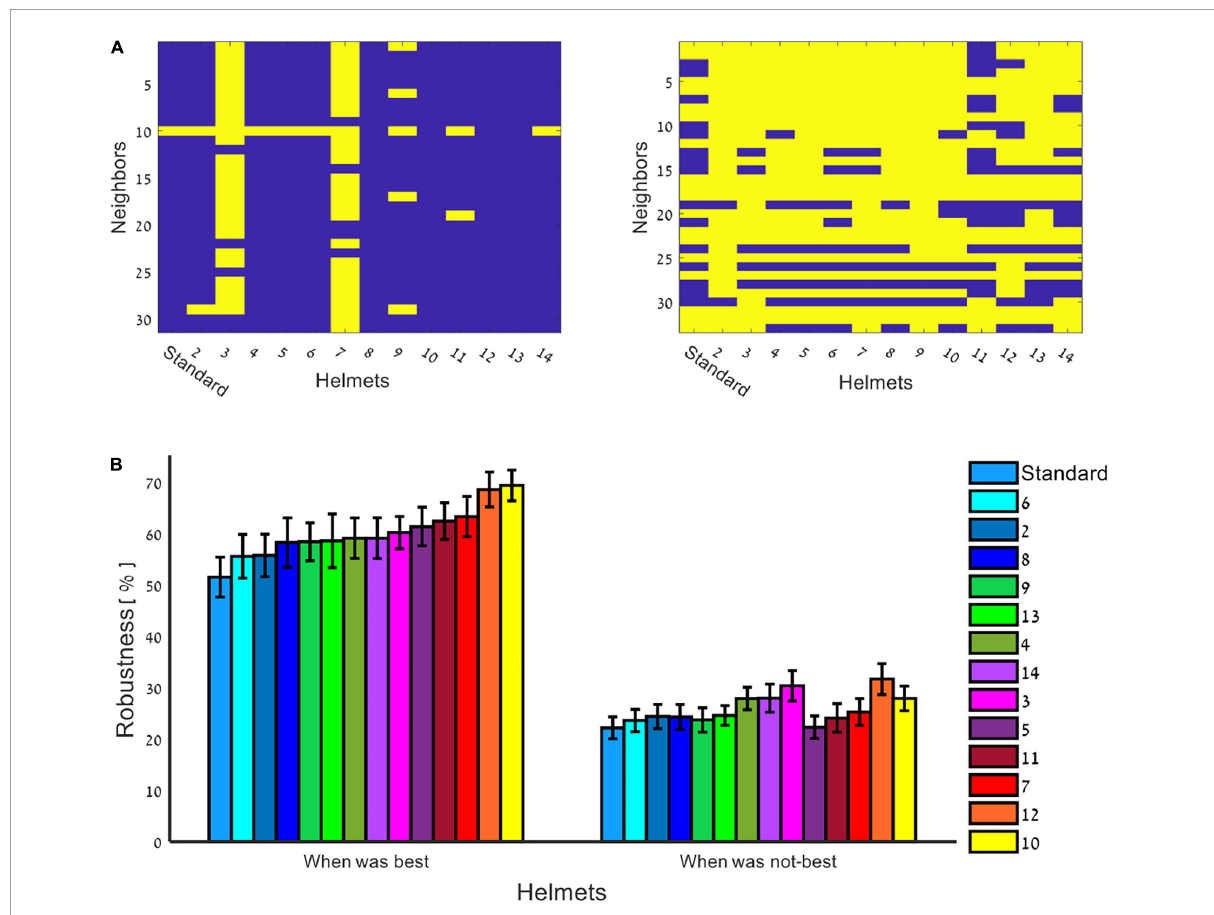
FIGURE4 Source estimations across neighbors via VMHs. The neighboring grid locations of each dipole of 100 dipoles pairs were used to evaluate the source estimations by the VMHs. (A) Binary matrices of (VMHs, Neighbors), each of a different dipole pair: yellow–if the specific VMH offer the best (most accurate) solution, and purple–otherwise. Examples: right panel–a dipole pair which shows relatively no preference to a specific VMH, and most VMHs offered the same quality of source estimations over neighbors; left panel–a dipole pair which shows source localization preference via specific VMHs. (B) The robustness of a helmet in the source estimation of a dipole pair is represented by calculating the percentage of neighboring dipoles for which a specific helmet offered the best solution out of all helmets, while dividing into cases in which the specific helmet offered the best solution per an originally placed dipole pair (left panel), and to cases it did not for other original dipole pairs (right